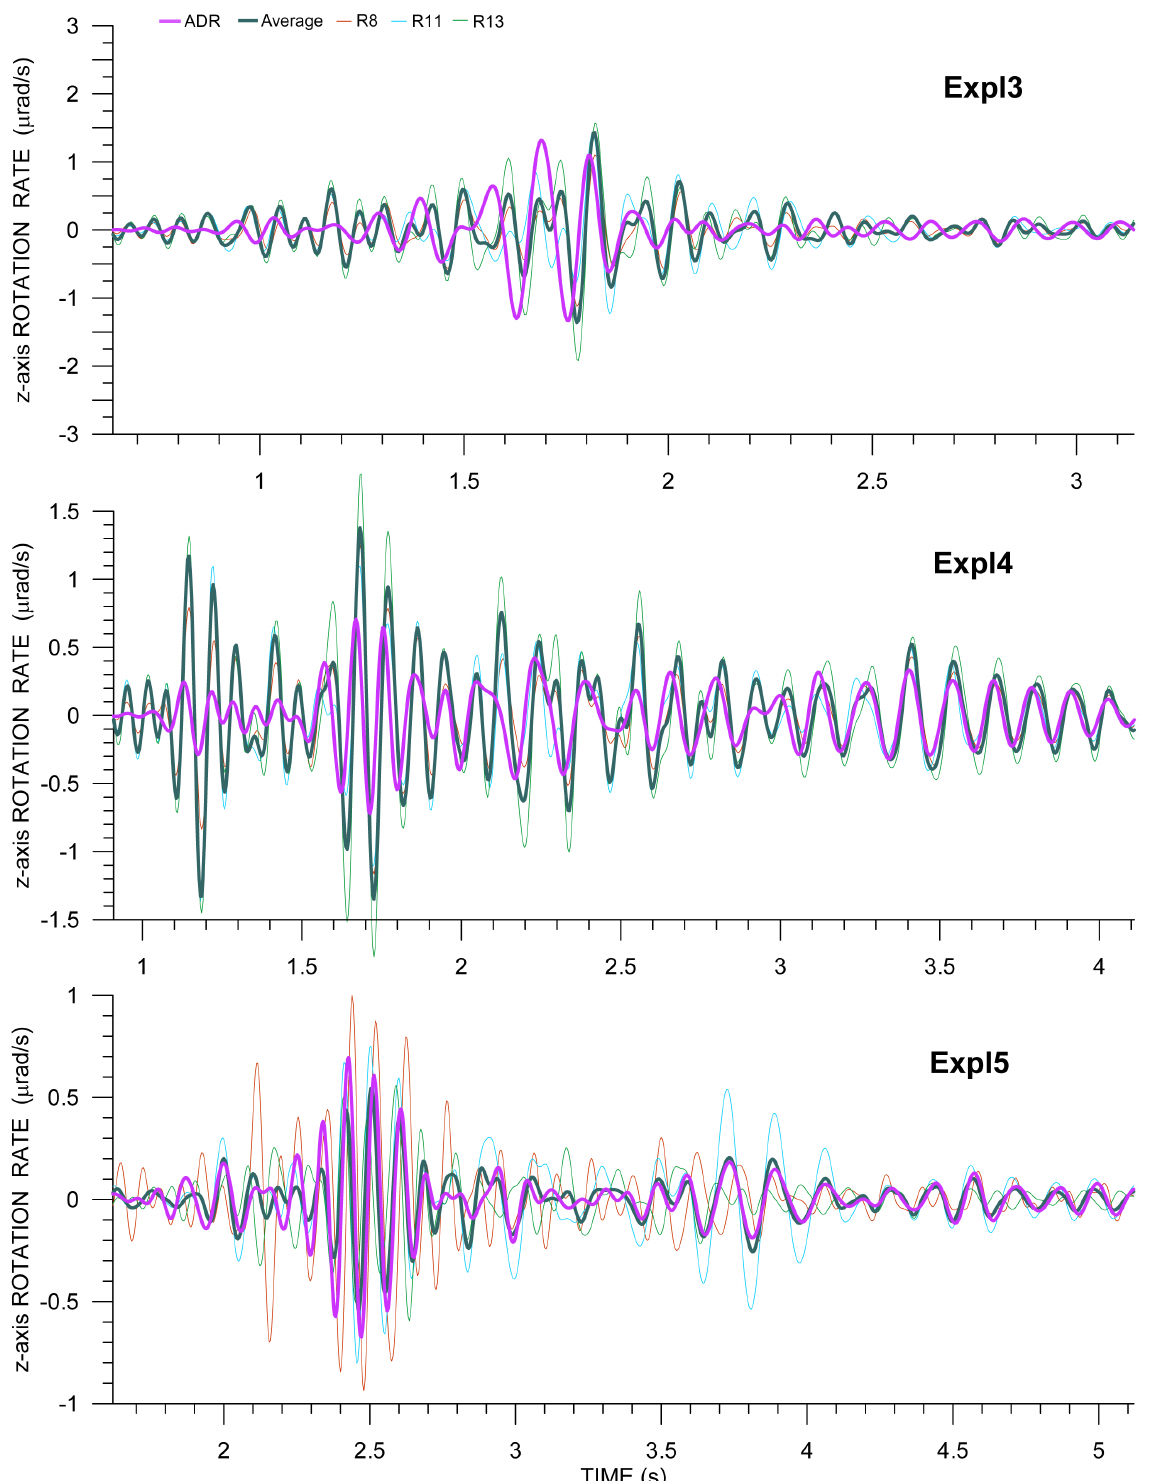
Figure 13. Comparison of ADR vertical rotation rate (purple) with that from R8 (thin red), R11 (thin light blue), and R13 (thin green), and with the average transverse rotation from those three instruments (pine green) for explosions Expl3, Expl4 and